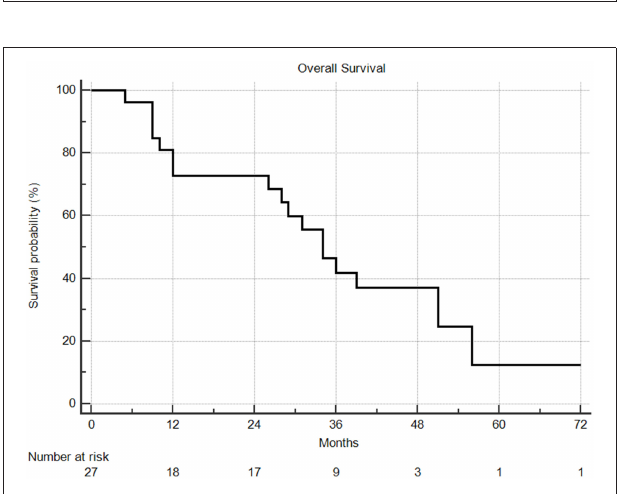
FIGURE 5 | Overall survival from time of SBRT. Two and 5 year overall survival were 63% and 9%,